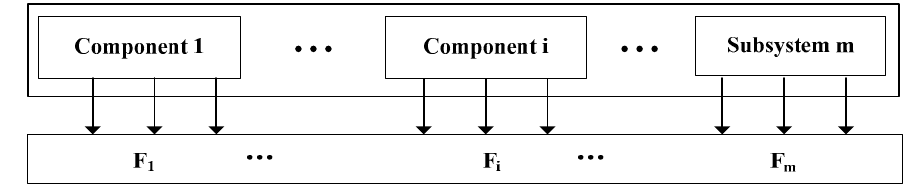
Figure 1. Structure of typical multi-component systems.